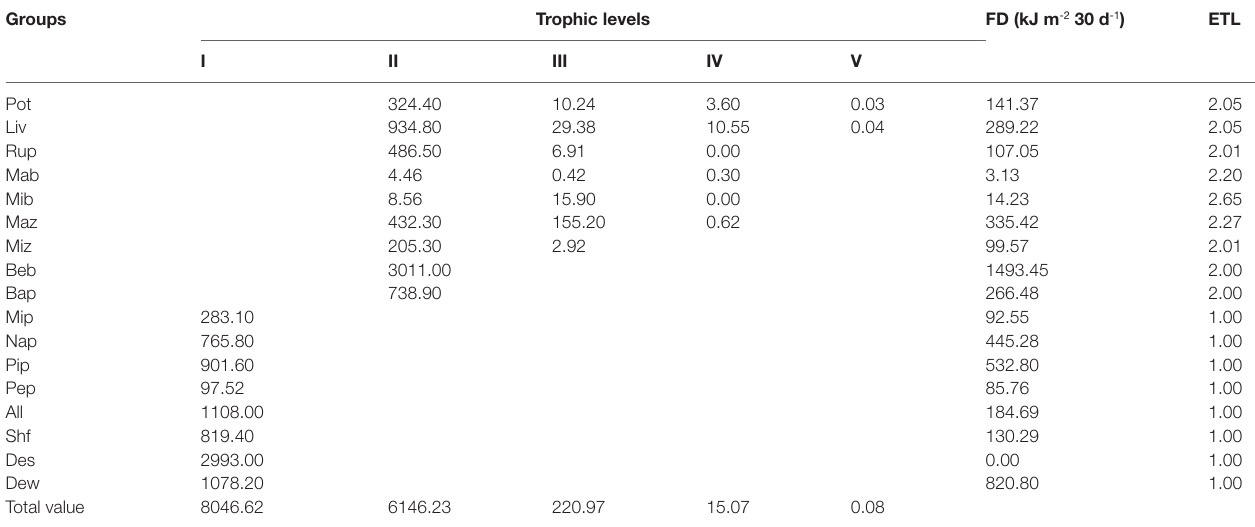
Group abbreviations of each functional group as in Table 2 . FD, flow to detritus; ETL, effective trophic level.